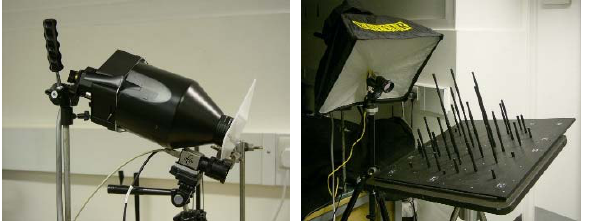
Figure 5. Flash light inside custom snoot with filter: (left) with perspex diffuser; (right) inside softbox. The Manhattan target was placed on a rotating platform with the centre approximately 0.5m from the camera so that it filled the field of view (Fig. 5 right). The lens was set to a focus distance of 0.5m and aperture of f/8 to ensure sufficient depth of field. The softbox diffuser on the flash was positioned close behind the camera on a tripod, so that light from the filtered flash reached the targets from angles all around the optical axis. This arrangement approximated a ring light. For each filter, a series of 12 or 16 images was taken with systematic changes of orientation and rotation of the Manhattan object relative to the camera. The monochrome images were captured as 12-bit files in PNG format. The sets of images of the test object and its illuminated targets were analysed by Vision Measurement System (VMS) software (Version 7.6). In order to maximise the target contrast, the grey values of each image were scaled independently, and linearly, by finding percentile points at 10% and 99.95% in the histogram and mapping them to 10% of the 8-bit output range for black and 75% for white. This method allows the grey value mapping to accommodate a wide range of image illumination attributable to the different filter attenuation, output power of the xenon arc flash and spectral sensitivity of the uEye CMOS array to each wavelength group (Fig.